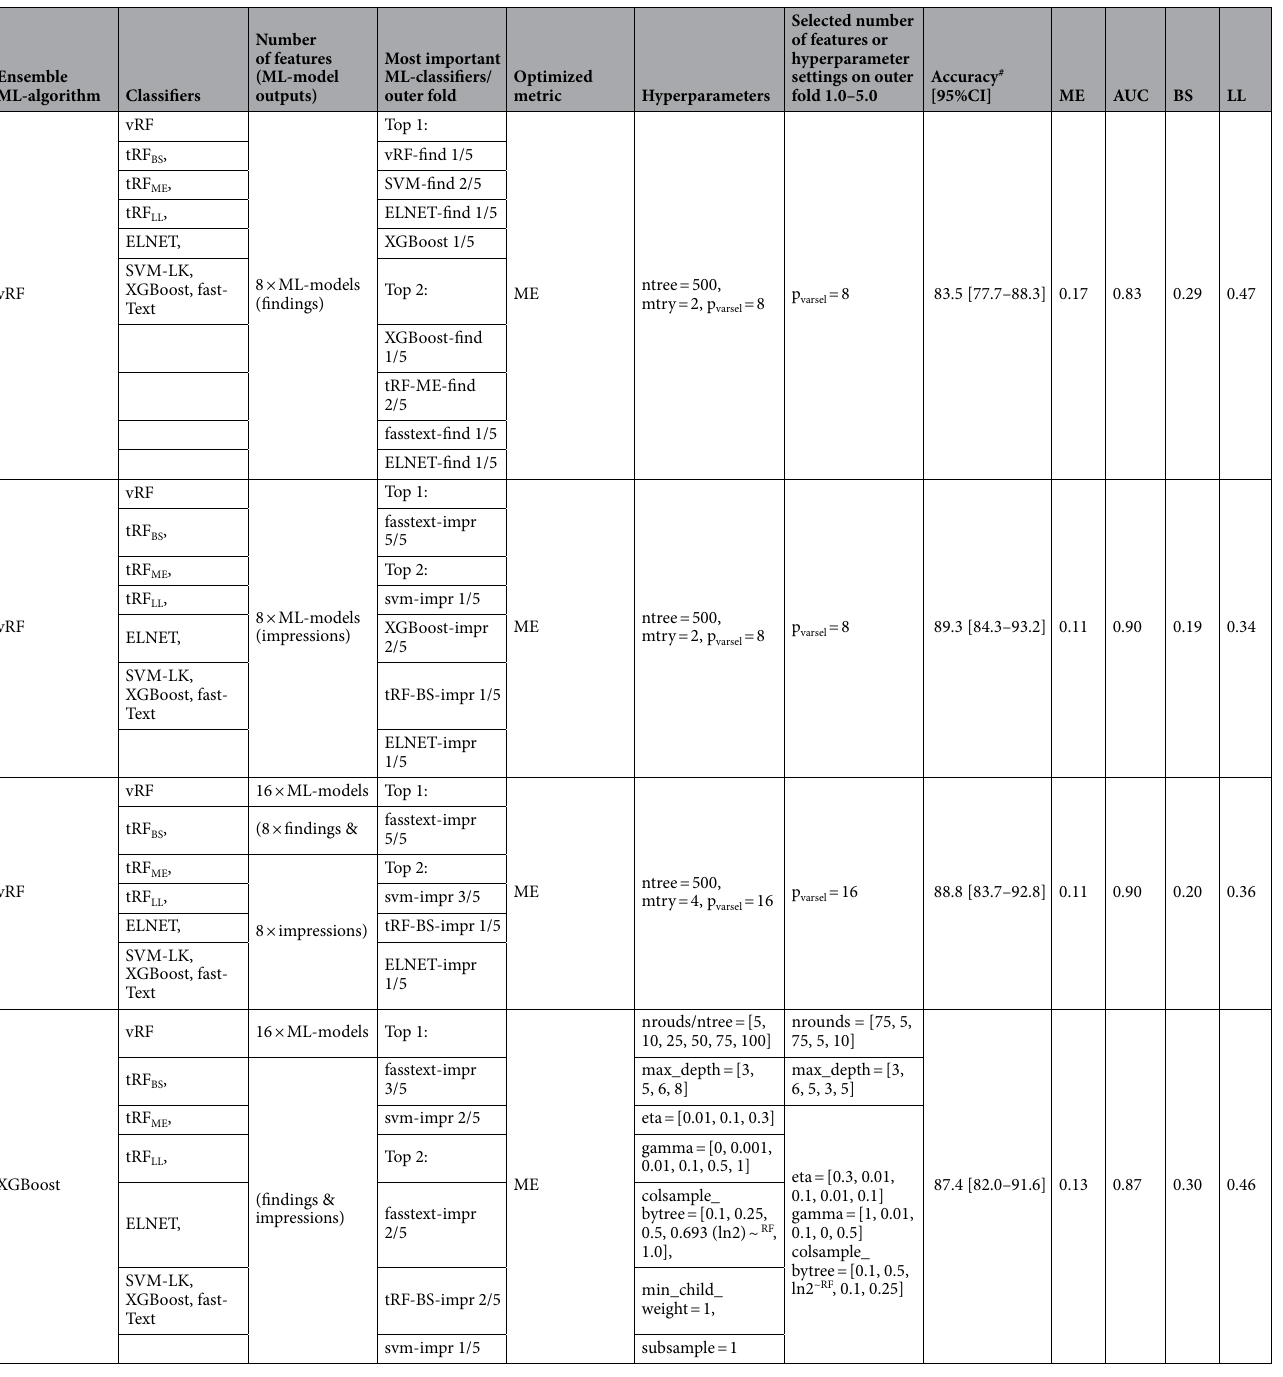
Table 3. Summary table of performance measures of the second layer meta/ensemble learners (random forests and boosted trees) combining the predictions of all RadLex-based ML base classifiers from the findings and impression sections. AUC: multiclass area under the ROC after Hand and Till (that can only be calculated if probabilities are scaled to 1), us var.filt: unsupervised variance filtering using p = 300 most variable RadLex terms -this step was previous of training to prevent information leakage, BS: Brier score, ME: misclassification error, LL: multiclass log loss, vRF and tRF: vanilla- and tuned random forests, ELNET: elastic net